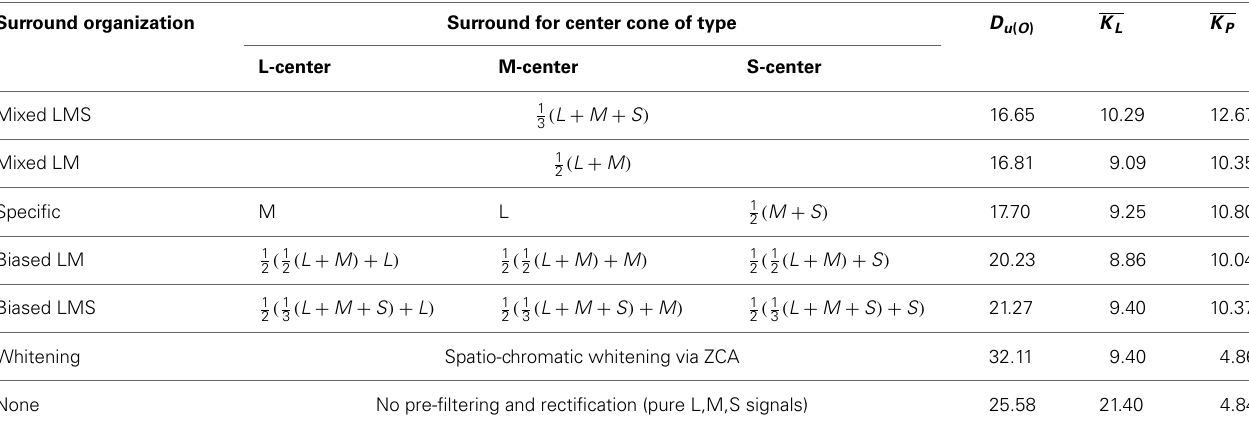
Table 1 | Kullback-Leibler-Divergence from uniformity, mean lifetime kurtosis K L and mean population kurtosis K P for different surround configurations and preprocessing